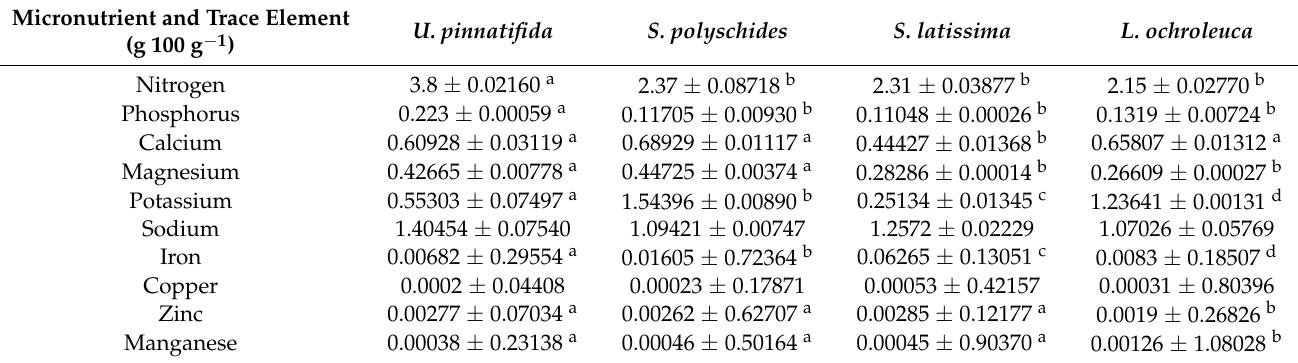
Table 1. Micronutrient and trace element composition of U. pinnatifida , S. latissima , L. ochroleuca , and S. polyschides . Results are expressed in mean ± standard error ( n = 2; dry weight basis). Statistically significant differences in the same element content among the species are expressed by different